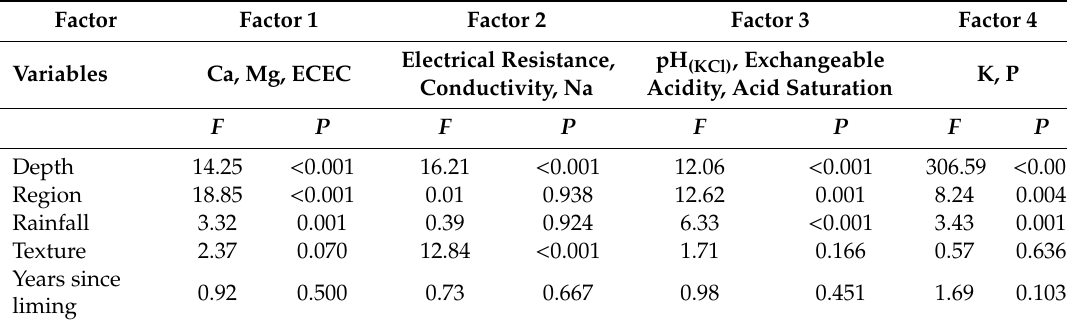
Table 3. ANOVA F statistics and P -values for the fixed e ff ects in the mixed models of soil of depths (0–5, 5–15, and 15–30 cm), region (Swartland vs. southern Cape), annual rainfall, soil texture, and years since previous liming. ECEC = E ff ective cation exchange capacity.